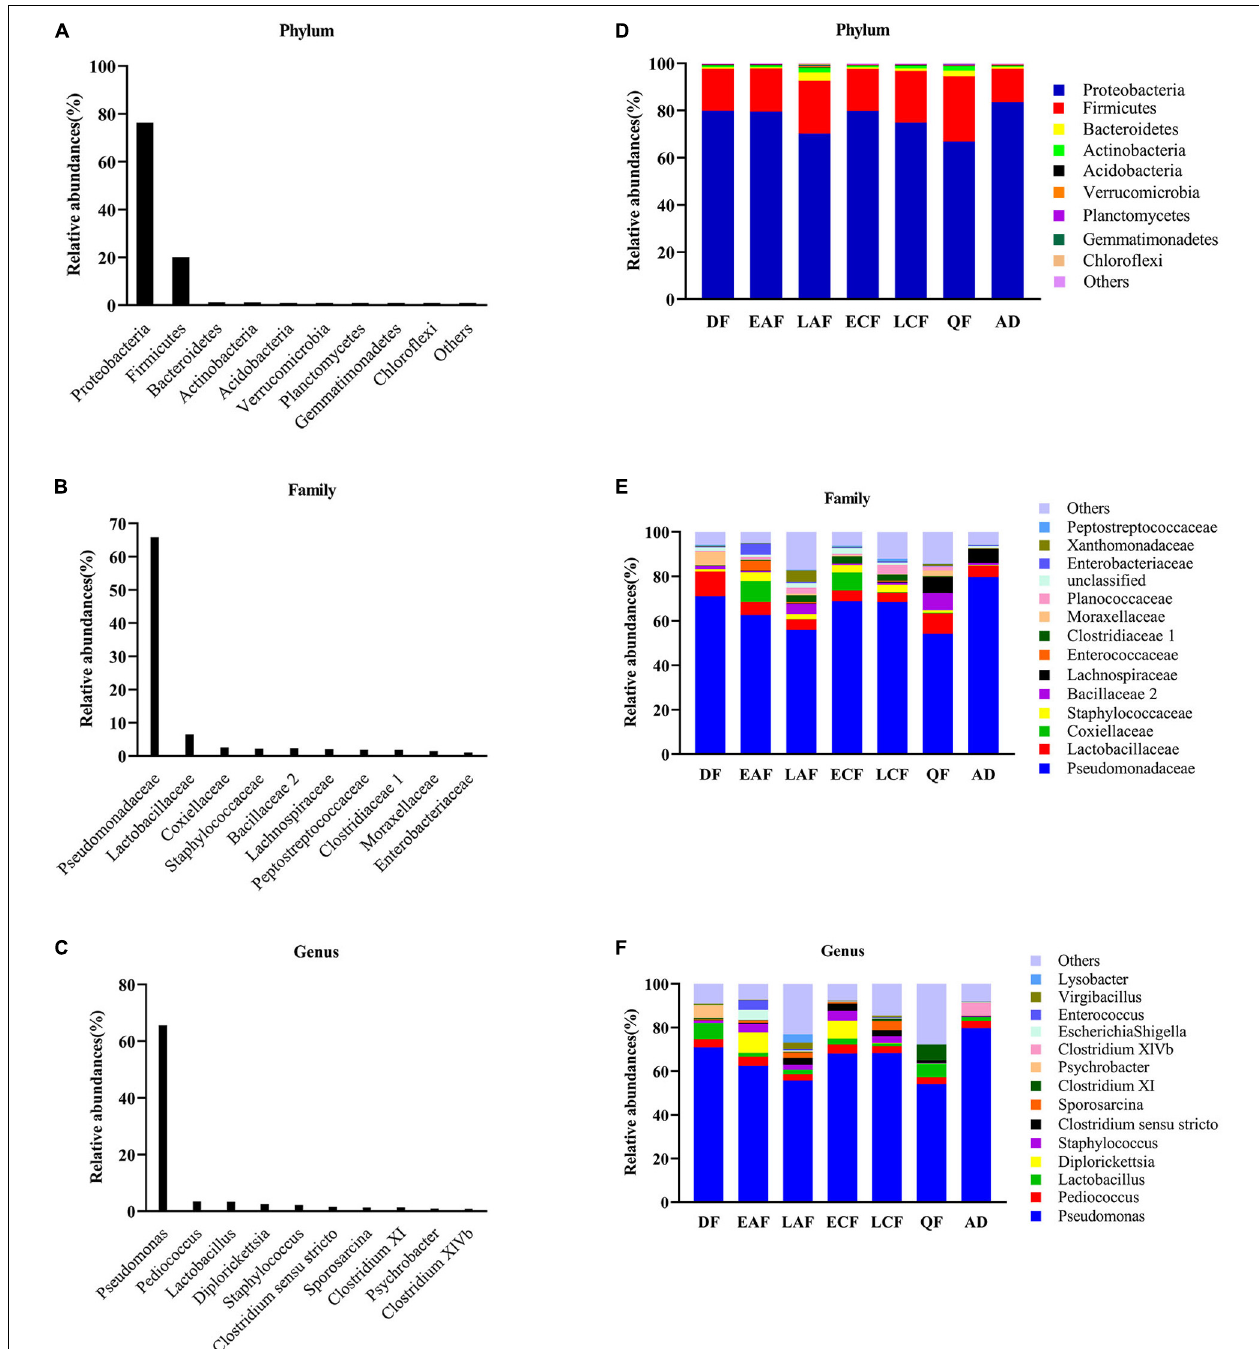
FIGURE 1 | Relative contribution of the dominant phyla in all samples. (A) Phylum; (B) family; (C) genus. Relative abundance of these taxa in the seven sample groups. (D) Phylum; (E) family; (F) genus. AD refers to eight samples of adult birds; DF refers to eight samples from the downy feather stage; EAF refers to eight samples from the early acicle feather stage; LAF refers to eight samples from the later acicle feather stage; ECF refers to eight samples from the early contour feather stage; LCF refers to eight samples from the later contour feather stage; QF refers to five samples from the qi feather